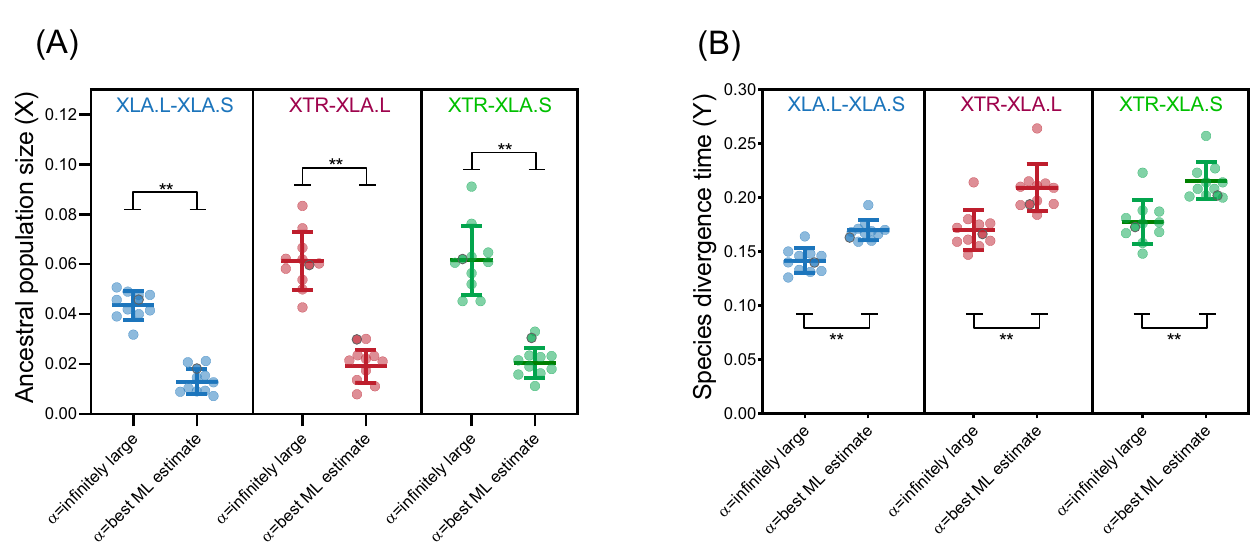
Fig 3. Best maximum likelihood estimates of X = 4 Nμ and Y = 2 μt . Estimates were used to calculate ancestral population size and species divergence time, respectively (in ancestor of XLA-XTR or XLA.S-XLA.L). These estimates were significantly different compared to those using infinitely large α ( �� p < 0.0001, t-test). Line bars represent mean ± s.d.; each point represents each chromosome, with genome-wide results indicated by dark circles.